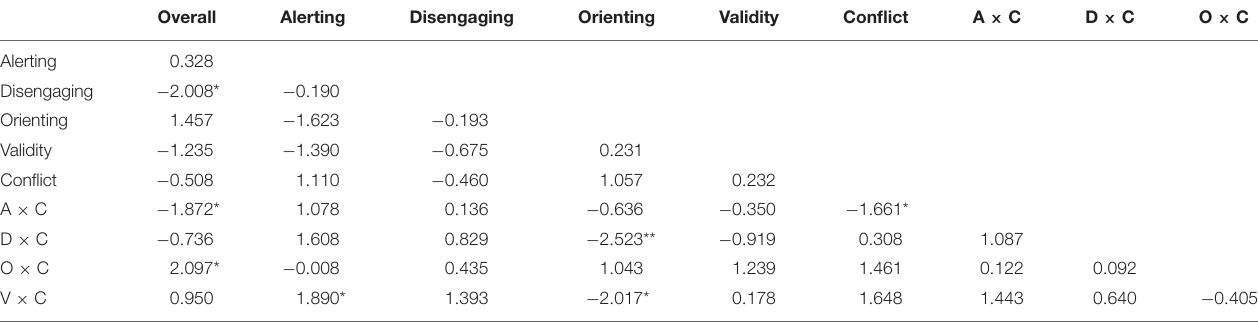
TABLE 7 | Comparison of the correlation coefficients for the attentional effects in different groups in the ANT-A. Overall Alerting Disengaging Orienting Validity Conflict A × C D × C O × C